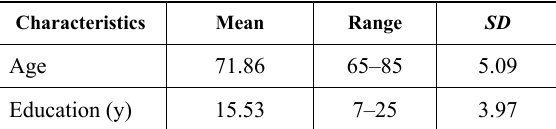
Table 1. Participant